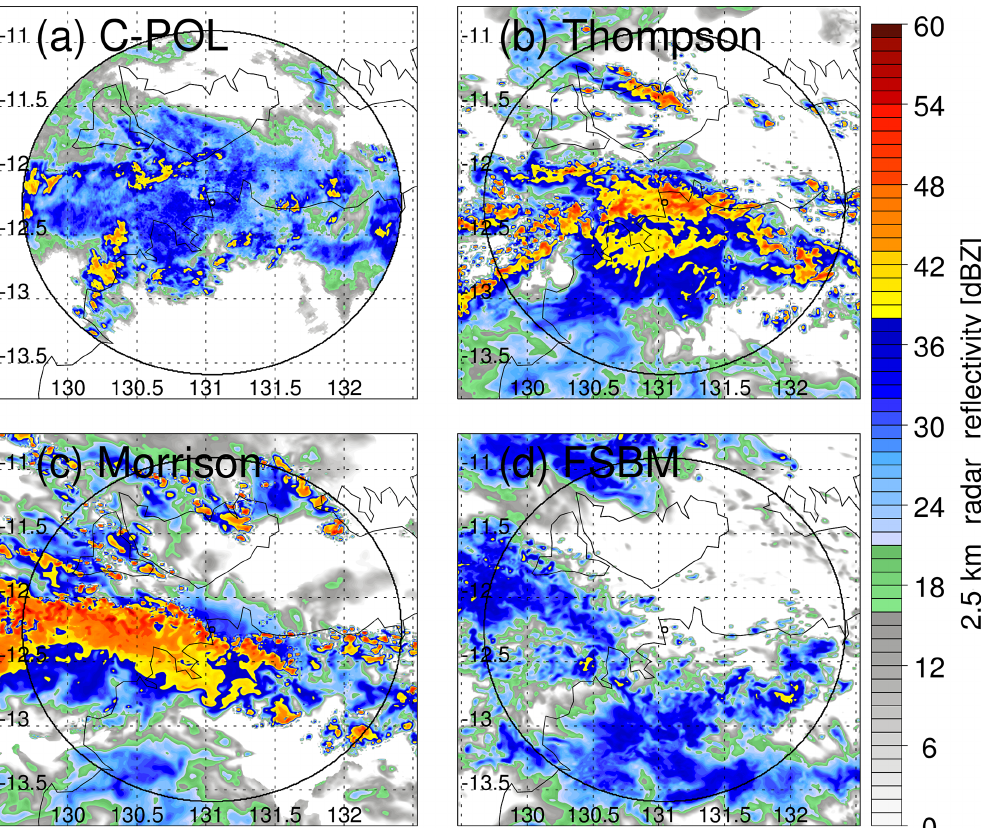
Figure 3. Representative 2.5km altitude horizontal radar reflectivity cross sections on 18 February 2014 at 18:00UTC for (a) C-POL observations, (b) Thompson, (c) Morrison, and (d) FSBM schemes. The circle indicates the 150km range ring of the C-POL